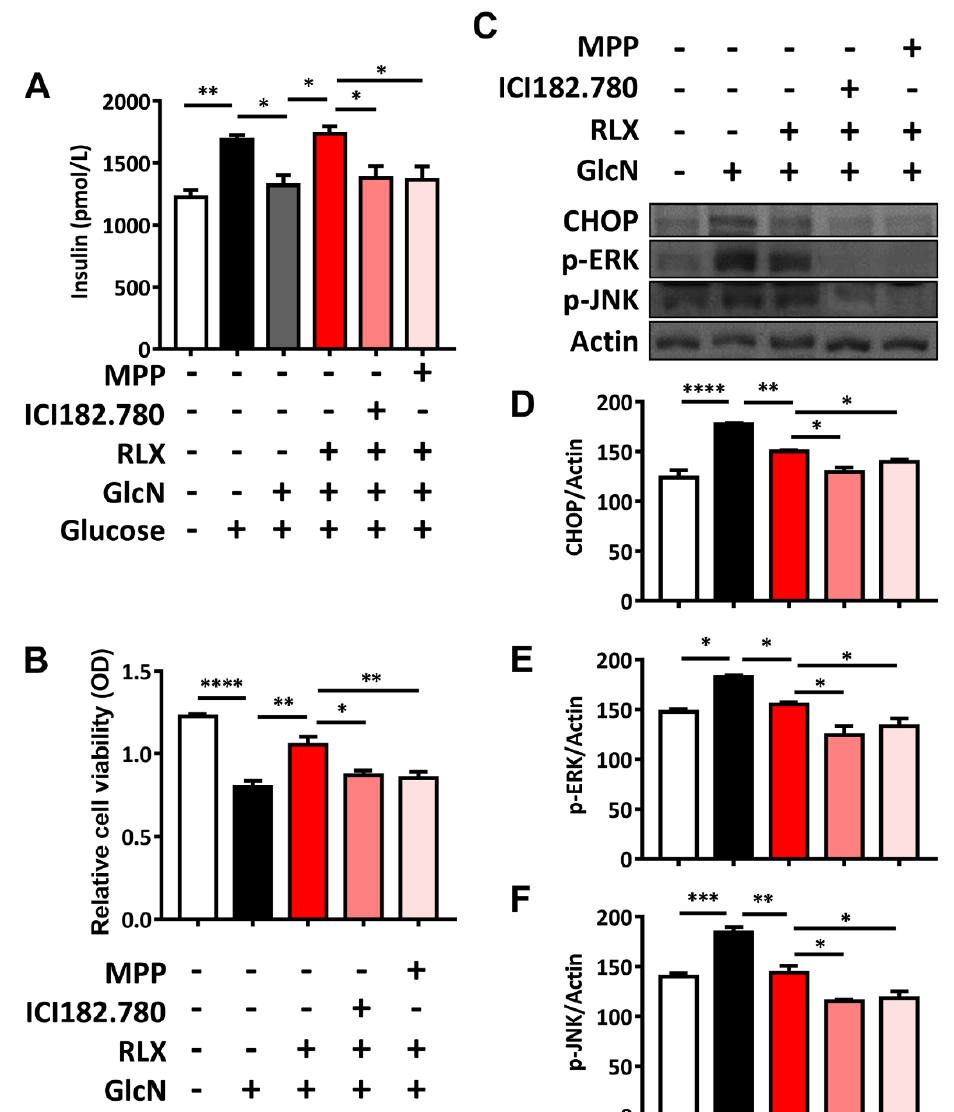
Figure 5. Extracellular insulin secretion, MTT assay, and Western blot analysis for the expression of ER stress-[associated proteins in MIN-6 cells. ( A ) Extracellular insulin secretion. Glucose increased extracellular insulin secretion, whereas GlcN reduced extracellular insulin secretion. RLX reversed GlcN-induced extracellular insulin secretion, whereas ICI 182,780 and MPP counteracted the effects of RLX. ( B ) MTT assay for cell viability. GlcN treatment reduced optical density in the MTT assay, whereas RLX counteracted this effect and even enhanced optical density. With combined ICI 182,780 and MMP treatment, the protective effect of RLX on cell viability was negated. ( C ) Western blot analysis for the expression of ER stress-associated proteins in MIN-6 cells: ( D ) CHOP, ( E ) p-ERK, and ( F ) p-JUK. GlcN treatment enhanced CHOP, p-ERK, and p-JNK expression, whereas RLX reversed these effects. Pretreatment with ICI 182,780 and MPP counteracted the reversal effect of RLX to protect against GlcN-induced CHOP, p-ERK, and p-JNK changes. Each bar represents the mean ± SEM. * p < 0.05; ** p < 0.01; *** p < 0.001; **** p < 0.0001.